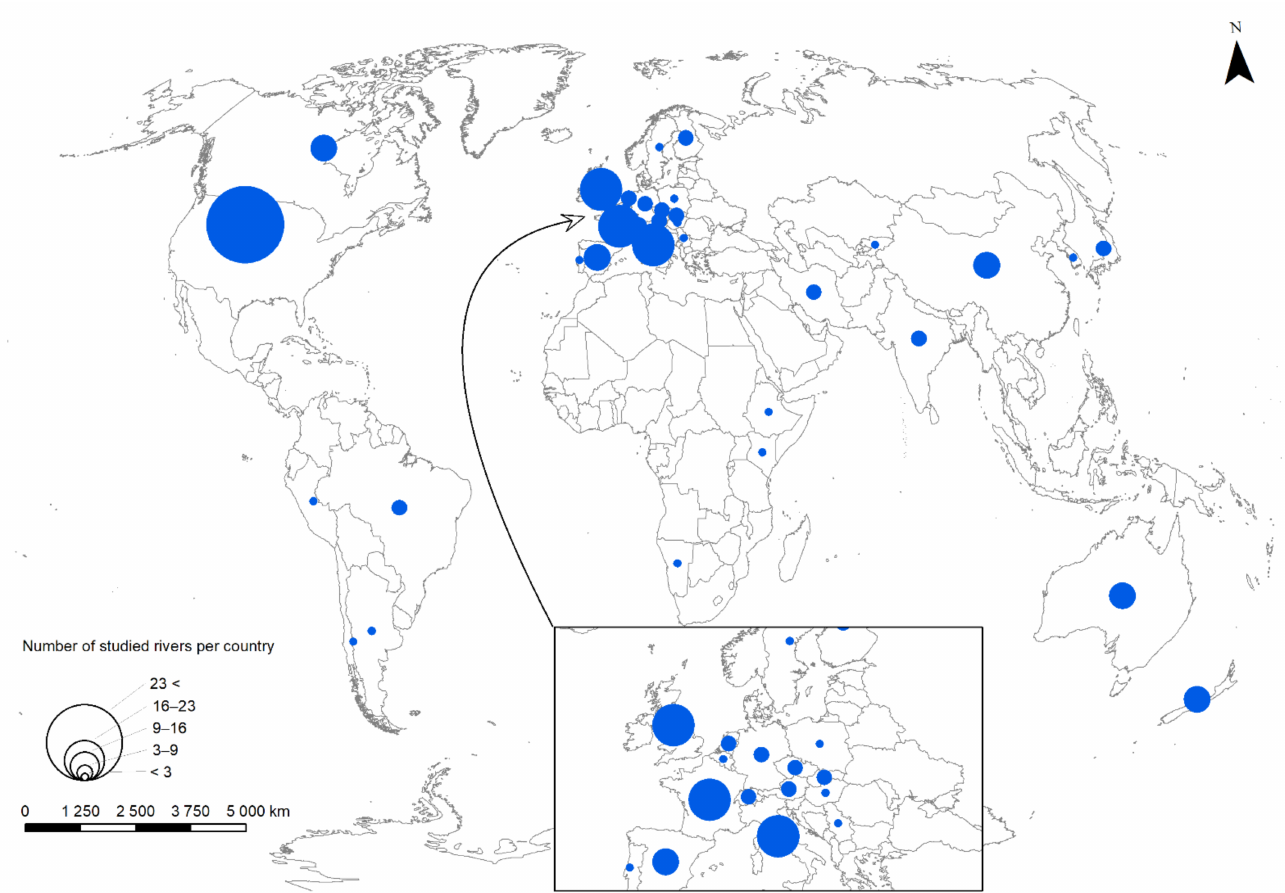
Figure 3. Locations of the areas studied as found from the WOS